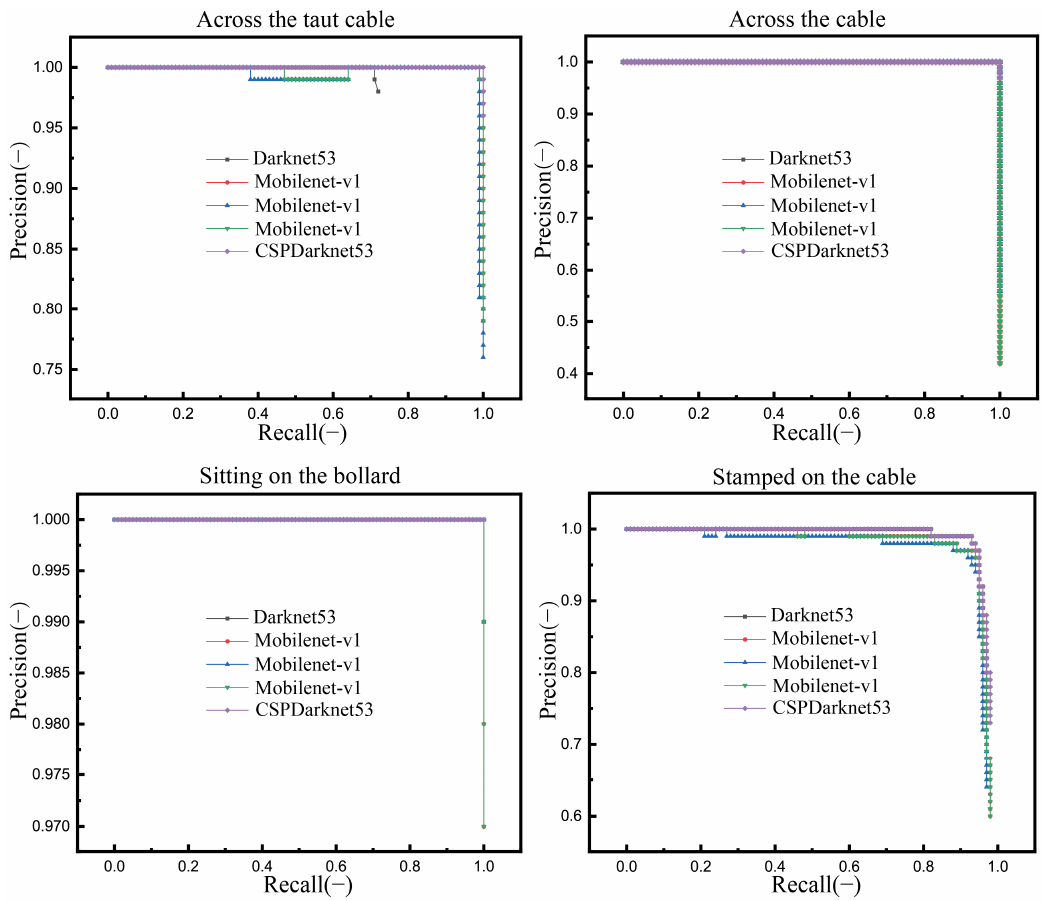
J. Mar. Sci. Eng. 2023 , 11 , 281 Figure 18. Comparison of AP diagrams after several unsafe behaviors. Figure 18. Comparison of AP diagrams after several unsafe behaviors.